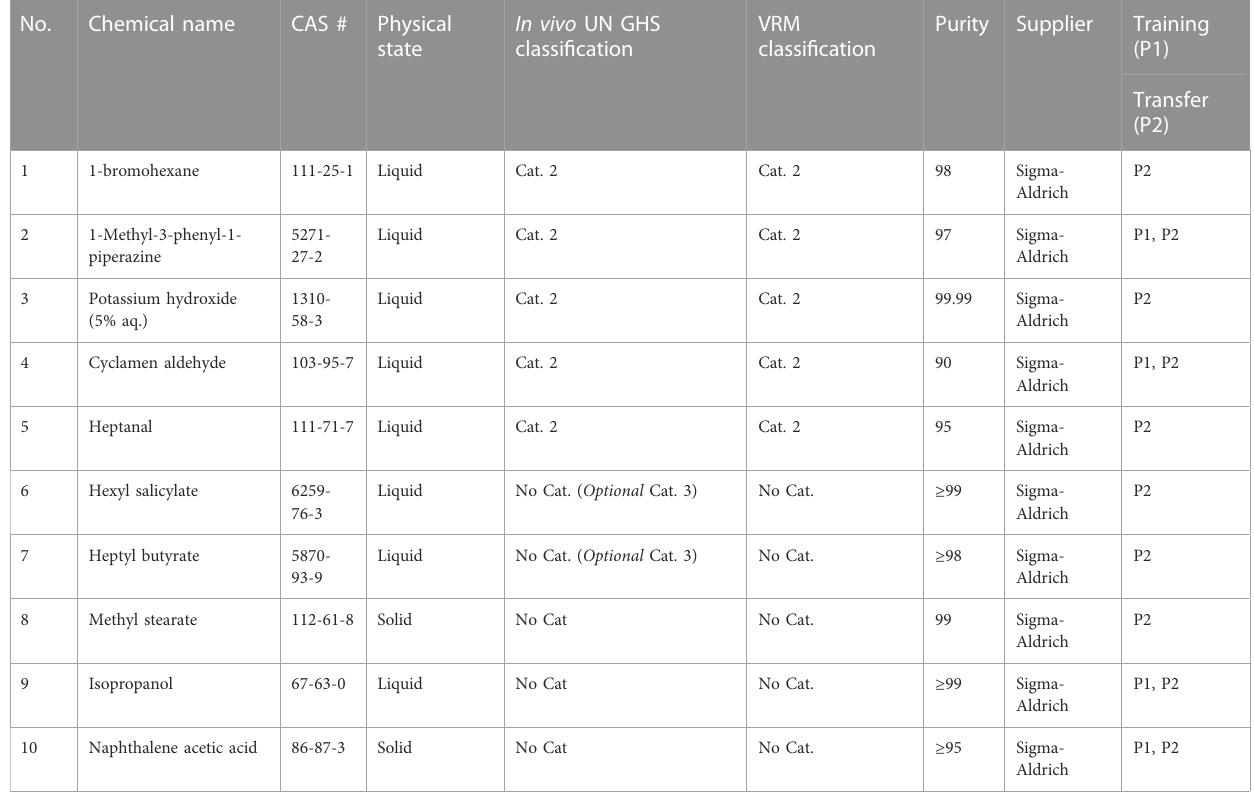
TABLE 1 Characteristics and UN GHS classi fi cation of the 10 test chemicals. No.